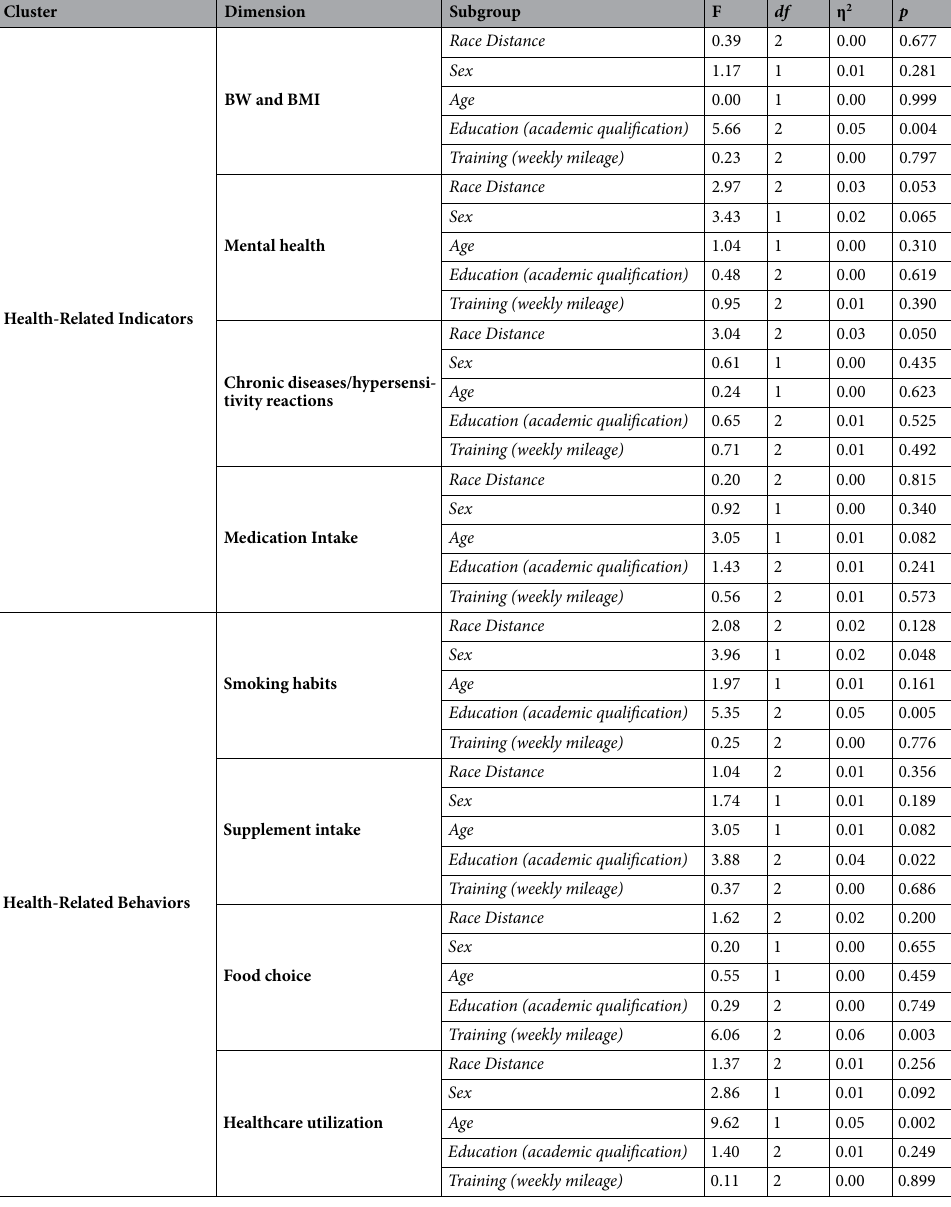
Table 5. MANOVA results for the eight dimensions of health status. BMI body mass index, BW body weight, df degrees of freedom. F F-value, η 2 partial effect (small: 0.01; medium: 0.059; large: 0.138), p p value for between-group